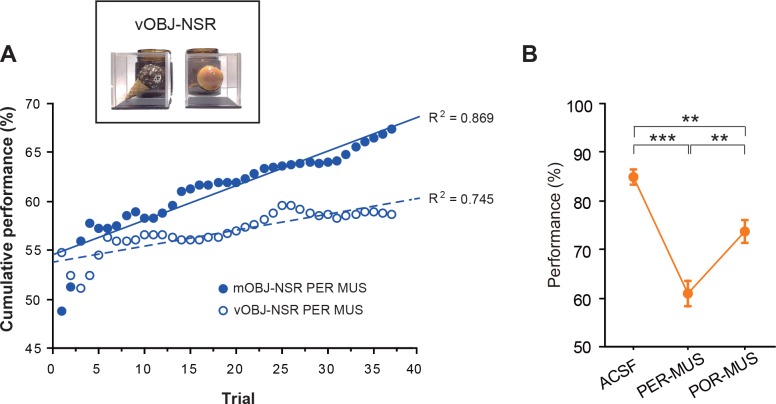
Multimodal versus visual OBJ-NSR tasks.(A) Cumulative performance of the PER-MUS group across trials in the multimodal OBJ-NSR (mOBJ-NSR) task and visual OBJ-NSR (vOBJ-NSR) task. We noticed that the performance of rats in the PER-MUS group in the mOBJ-NSR task improved in later trials, possibly suggesting a switch in the animal’s dependence on specific sensory modality (e.g., from visual to tactile) during object recognition. Such trend was not observed when objects were only sampled using visual modality in the vOBJ-NSR task. In the mOBJ-NSR task, the rats were allowed to sample the object stimulus using multiple sensory modalities such as vision and tactile information. The use of olfactory information, however, was controlled by cleaning the objects every 10 trials with diluted ethanol (70%), and replacing the object with its replica. Behavioral testing in the mOBJ-NSR task was followed by the vOBJ-NSR task. In the task, the object stimuli were encased in a transparent acrylic box (6 × 6 × 4 cm) with a sliding door to restrict the perceptual access to the object to the visual modality only. The general task procedures and object-response contingencies were the same between the two versions of the task. There was a significant difference between the slopes of the performance curves for the two tasks. (B) Behavioral performance in the vOBJ-NSR task (Mean ± SEM). Significant differences in performance were found among all groups (F(2,12) = 40.477, p<0.0001; one-way repeated ANOVA). There was a significant performance difference between ACSF and PER-MUS groups (p<0.0001), between ACSF and POR-MUS groups (p=0.001), and between PER-MUS and POR-MUS groups (p<0.001; Bonferroni-Dunn). **p<0.01, ***p<0.0001.10.7554/eLife.32657.008Figure 3—figure supplement 1—source data 1.Performance in the visual OBJ-NSR task.